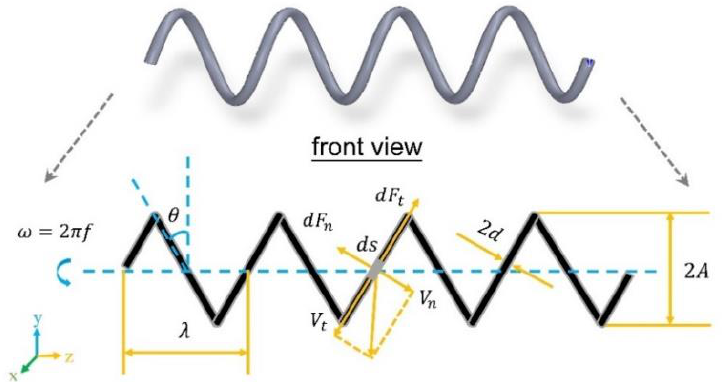
Figure 1. In the front view, the parameters of the helical swimmer can be expressed clearly, including f (rotating frequency), θ (helix angle), λ (pitch), d (line radius), A (helix radius), and forces acting on the micro-element ds .